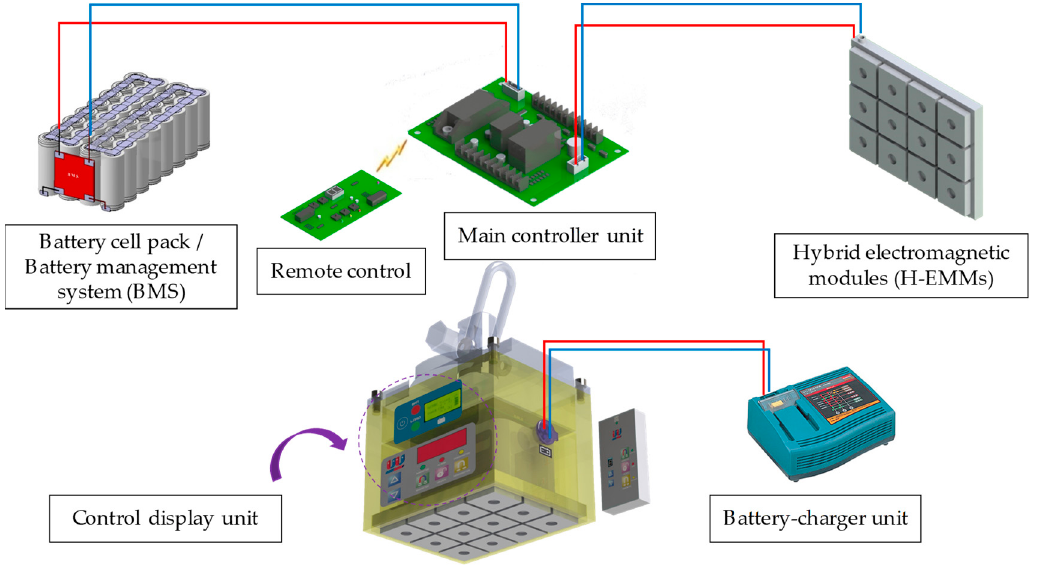
Figure 1. Configuration and major components of the hybrid electromagnetic clamping system (H-EMCS).